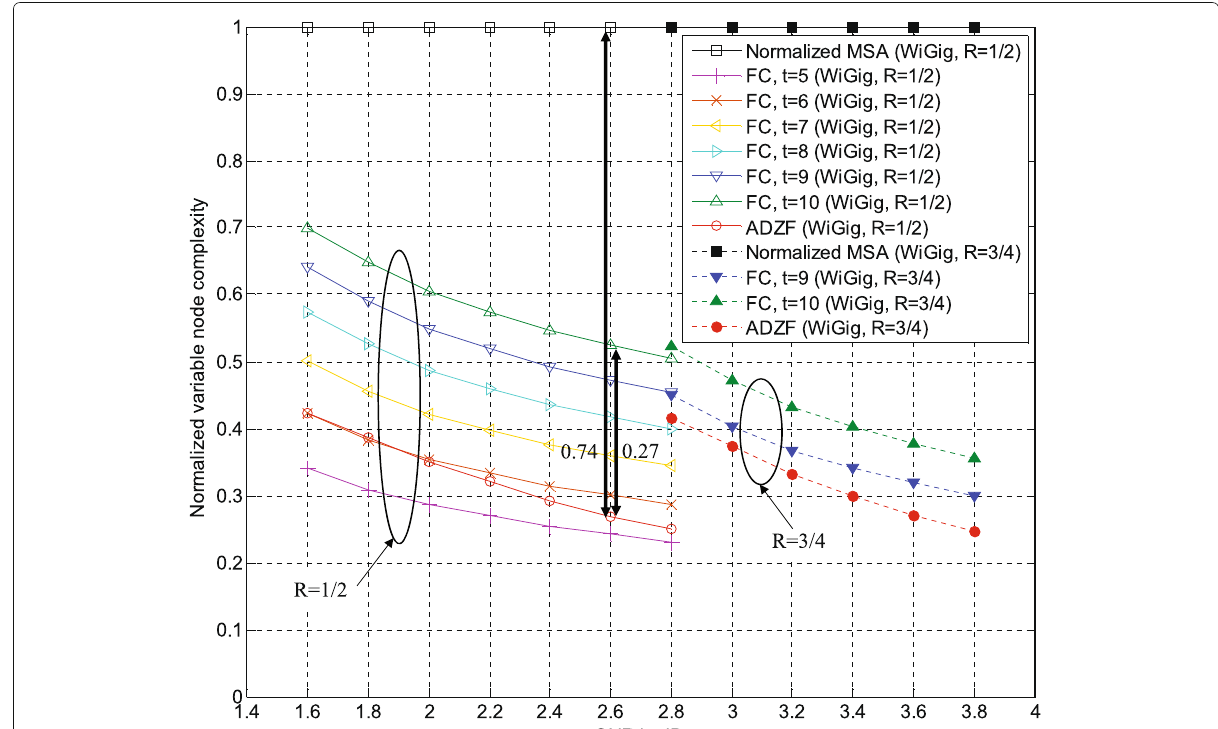
Fig. 13 Normalized variable node complexity of the normalized min-sum algorithm, conventional FC scheme, and proposed algorithm (ADZF)